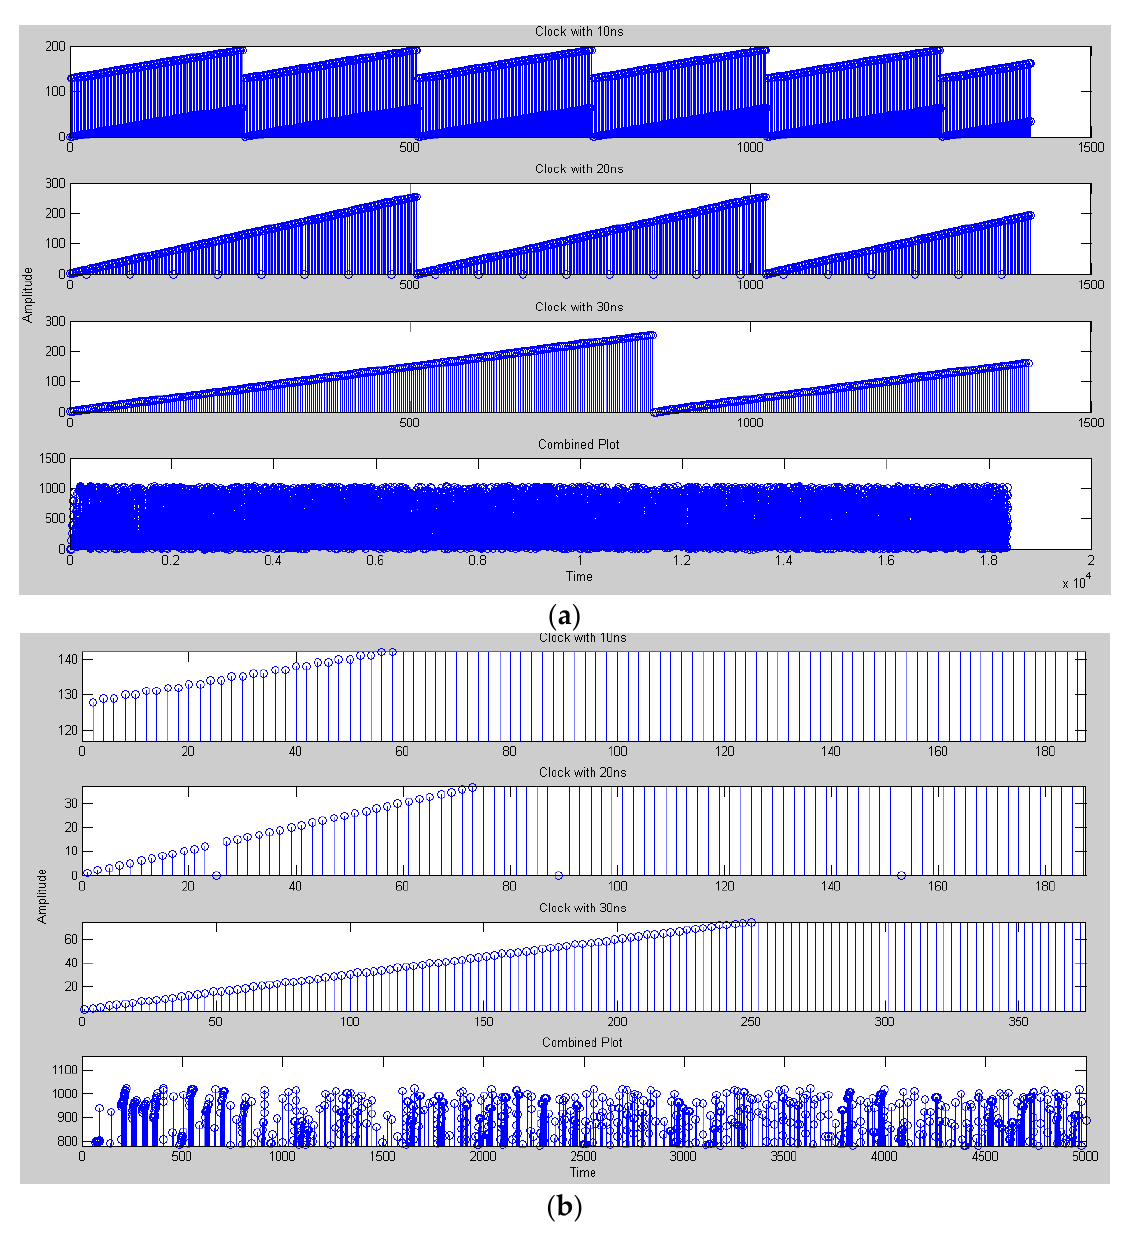
Figure 13. ( a ) Communication between PEs with delays, bit miss and double read − Compressed view. ( b ) Communication between PEs with delays, bit miss and double read − Expanded view.